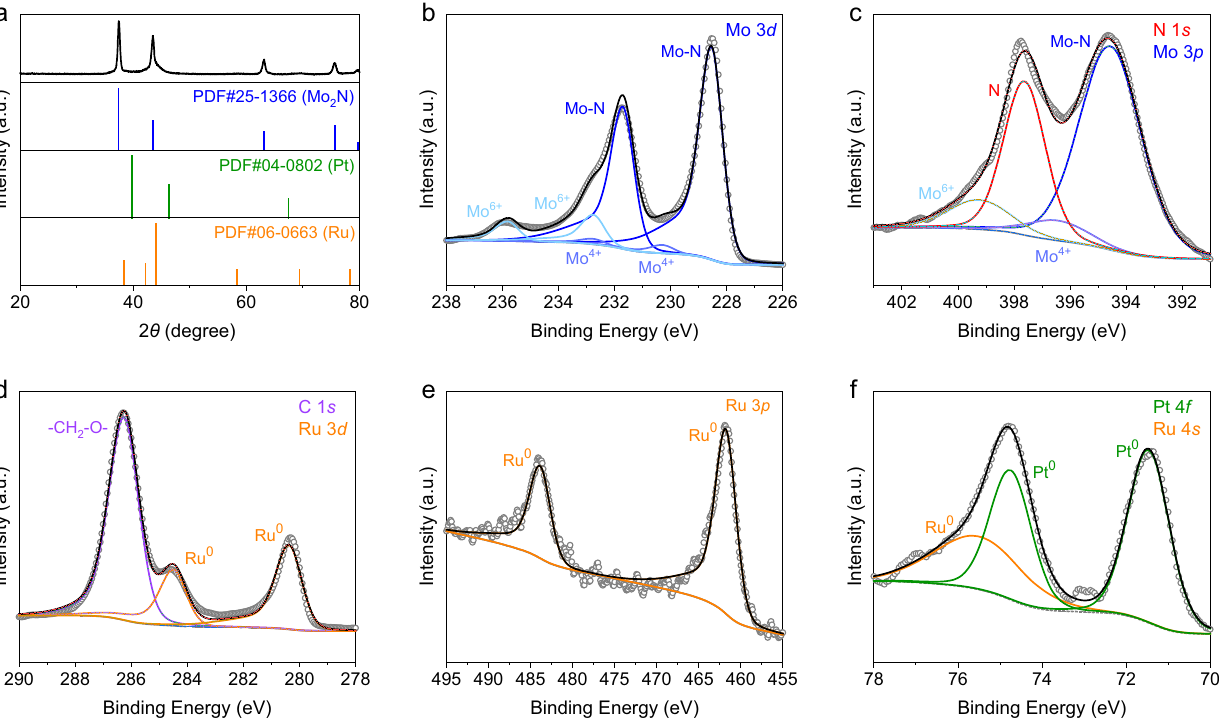
Fig.1|StructuralcharacterizationsofPt/Mo 2 N-Ru.a XRDpatternofPt/Mo 2 N-Ru. b Mo3 d , c N1 s andMo3 p , d C1 s andRu3 d , e Ru3 p ,and f Pt4 f andRu4 s XPSspectraof Pt/Mo 2